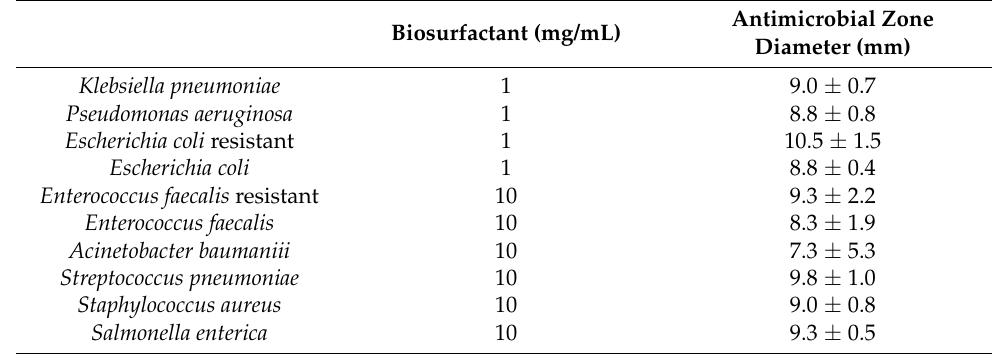
Table 1. In Vitro antimicrobial activity of the partially purified biosurfactant against multidrug- resistant pathogenic bacterial strains, using the agar susceptibility